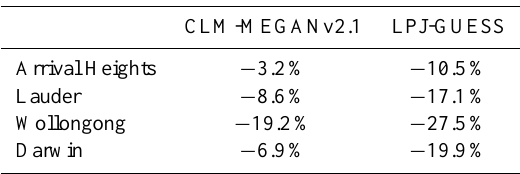
Figure 4. Deviations of model ensemble- and daily-mean CO columns from the observed FTIR CO columns with CLM- MEGANv2.1 simulation (red) and with LPJ-GUESS simulation (blue) respectively. The difference between the modelled CO columns from these two simulations are displayed in black symbols (CO CLM-MEGANv2.1 − CO LPJ-GUESS ). Table 3. Multi-annual averaged ensemble model mean deviations (%) from observed FTIR CO